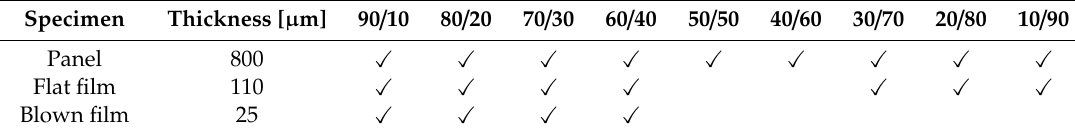
Table 1. Manufactured specimens made of PBAT / PLA blends with various